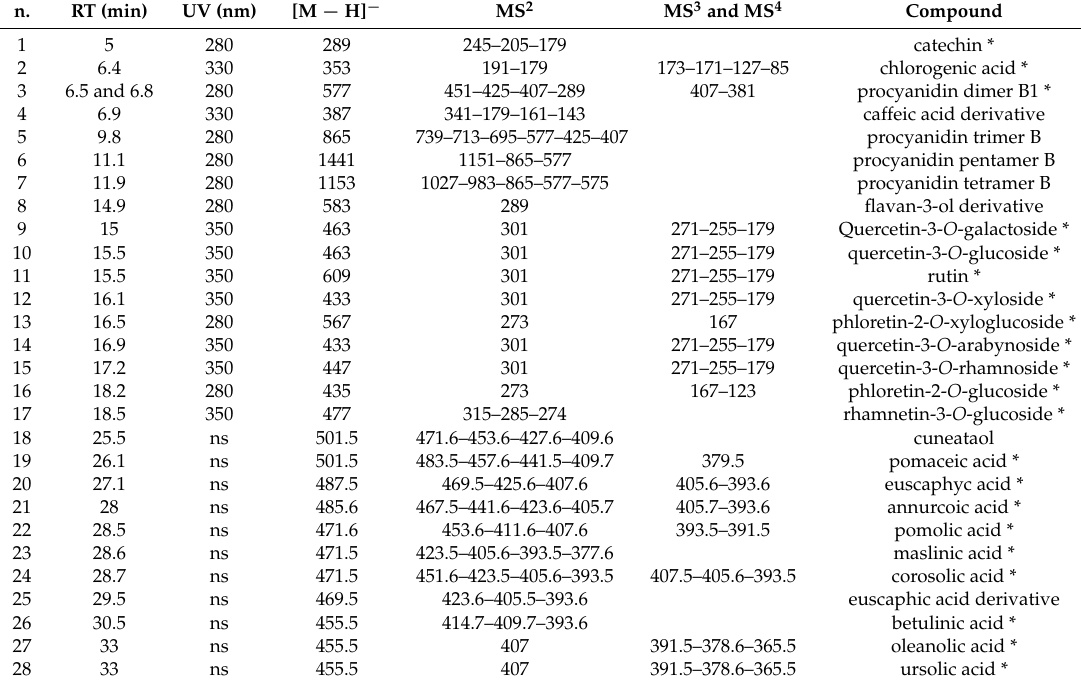
Table 1. The identified apple constituents according to their main m / z values and fragments; * compared with reference standards; ns: not